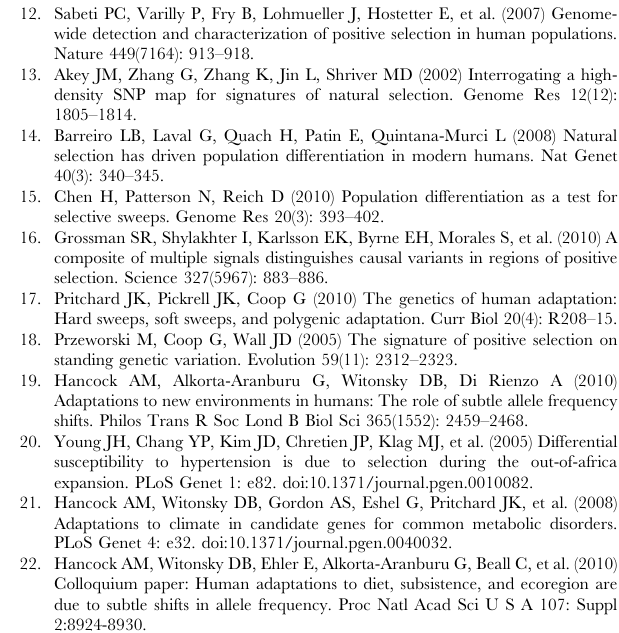
Figure S4 Frequencies of genes on chromosome 1 displaying different values of improvement of explained variance with three distinct models, comprising only pathogen diversity, subsistence strategies and climate conditions, using low-coverage new- generation sequencing data from 1000 Genomes Project. Table S1 List of sampled populations with specification of their country, continental group and number of genotyped individuals. Table S2 Chromosomal location for the entire set of analyzed SNPs.